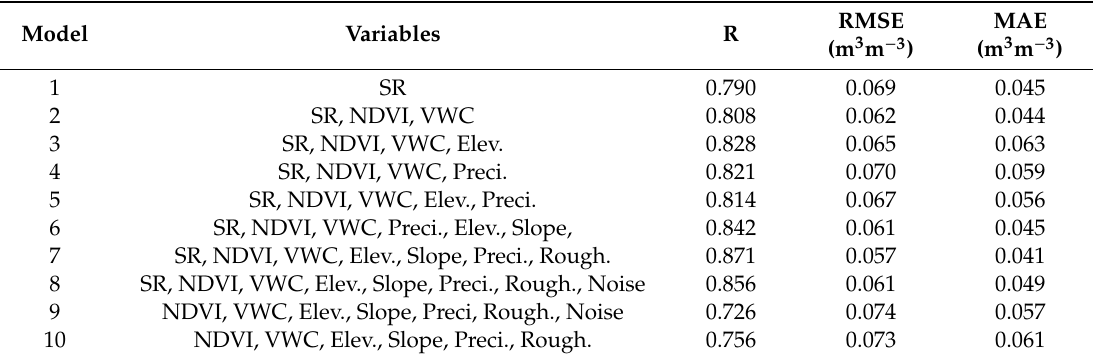
Table 4. Variables used to fit the